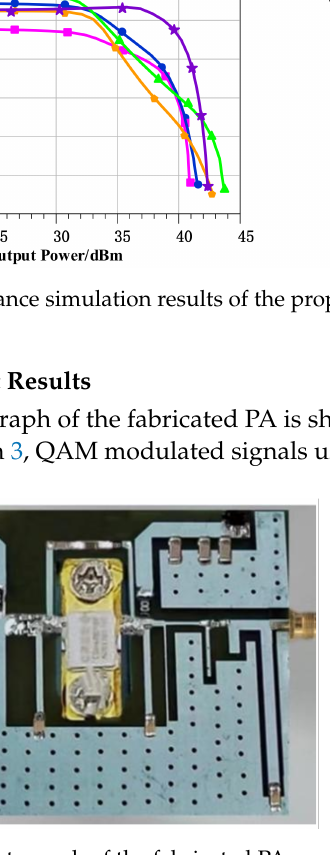
Figure 14. The photograph of the fabricated